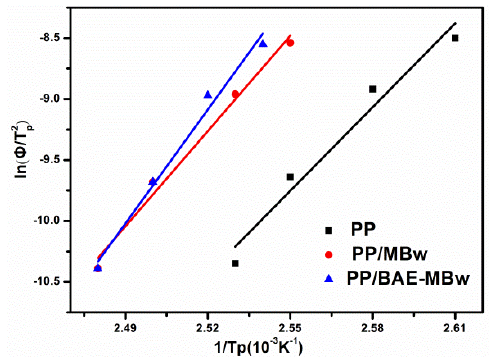
Φ / T 2 / T p for PP and PP p ) versus 1